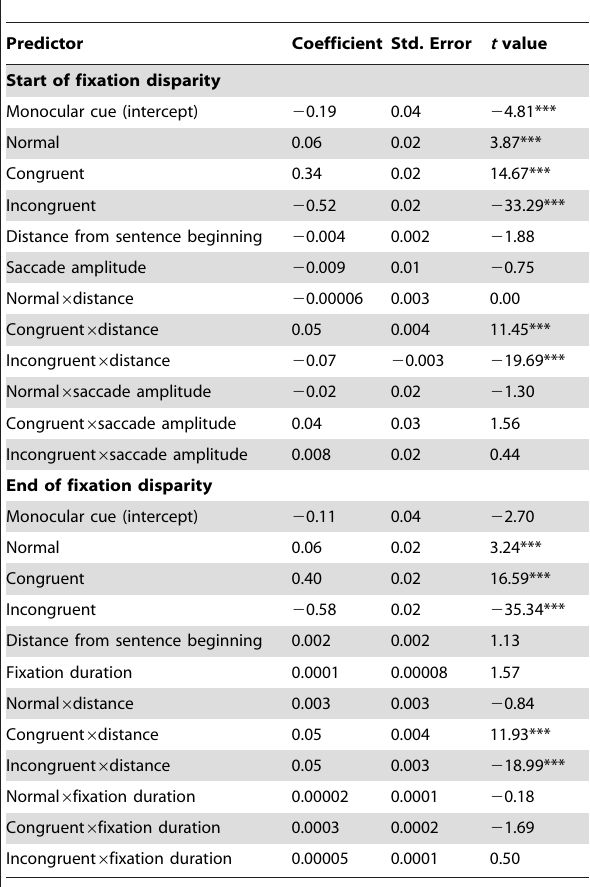
Table 2. The lme models for start and end of fixation disparity.